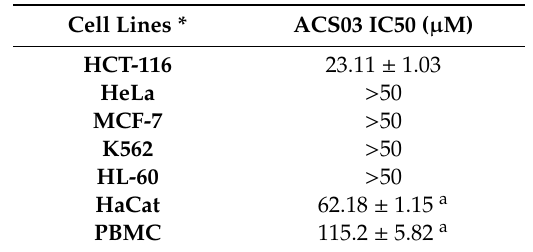
Table 1. Cytotoxicity of ACS03 against various cell types by MTT (3-(4,5-dimethylthiazol-2-yl)-2,5- diphenyltetrazolium bromide) assay. Mean IC50 (half maximal inhibitory concentration) values were calculated from cell growth curves ( n =